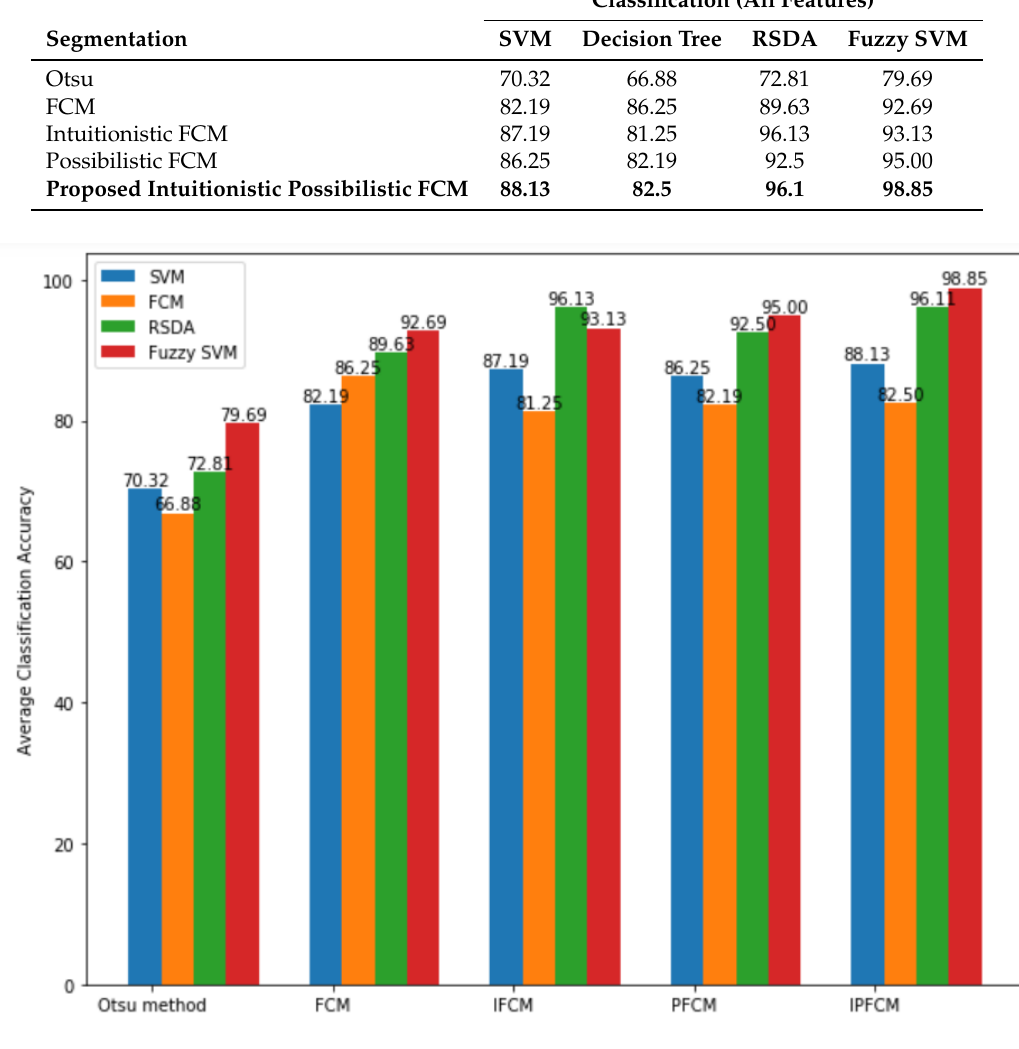
Figure 7. Comparative Classification average accuracy